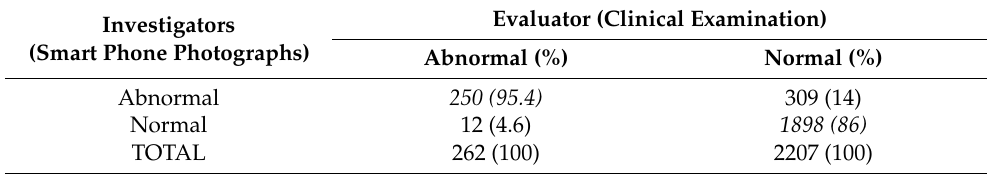
Table 4. Sensitivity and specificity considering photographs with disagreement as abnormal.